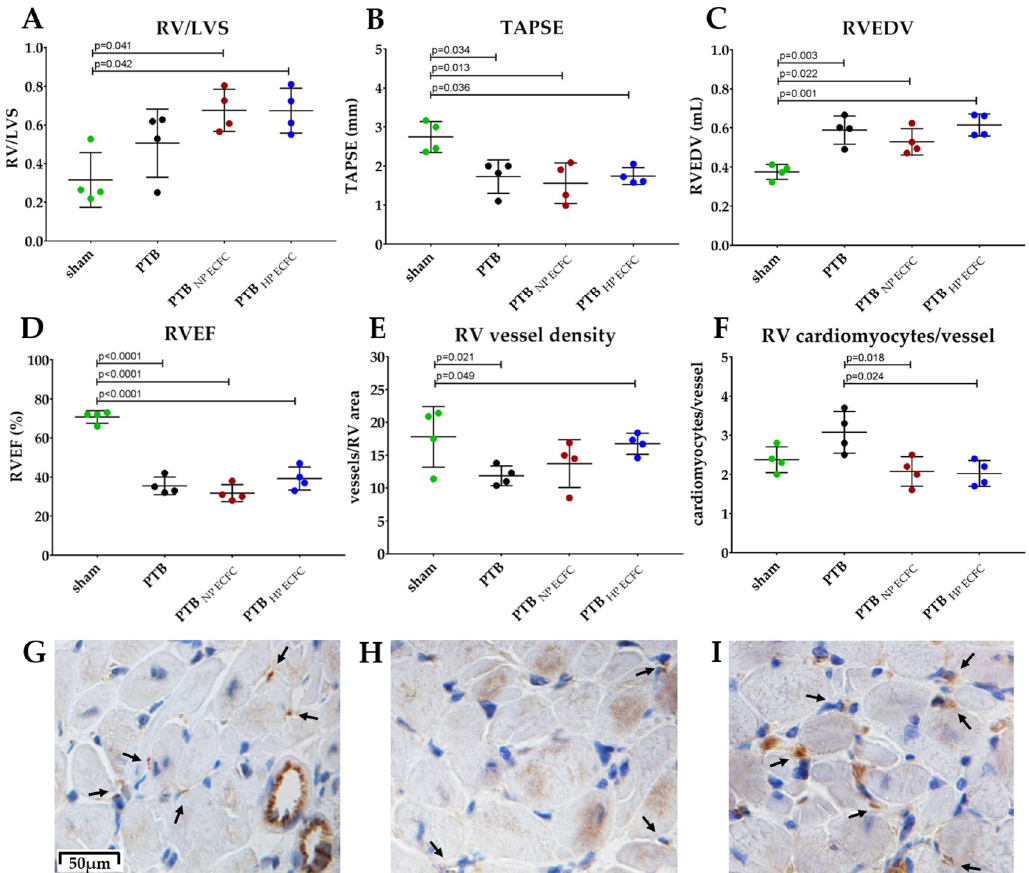
Figure 4. Transplantation of PAH ECFC did not induce reversal of the hemodynamic profile in PTB rats of chronic RV failure. ( A ) RV/LVS weight-ratio was comparable among sham rats (0.32 ± 0.14, green), PTB rats (0.51 ± 0.18, black), PTB rats transplanted with normal proliferative PAH ECFC (0.67 ± 0.11, red), or PTB rats transplanted with highly proliferative PAH ECFC (0.67 ± 0.11, blue). ( B ) TAPSE at evaluation shown of sham (2.7 ± 0.3 mm), PTB (1.7 ± 0.3 mm), PTB normal proliferative PAH ECFC (1.6 ± 0.5 mm), or PTB high proliferative PAH ECFC (1.7 ± 0.19 mm). ( C ) RVEDV of sham (0.38 ± 0.04 mL), PTB (0.59 ± 0.07 mL), PTB normal proliferative PAH ECFC (0.53 ± 0.07 mL) and PTB high proliferative PAH ECFC (0.62 ± 0.06 mL). ( D ) RVEF of sham (71 ± 3%), PTB (36 ± 5%), PTB normal proliferative PAH ECFC (32 ± 4%) and PTB high proliferative PAH ECFC (39 ± 6%). ( E ) Quantification of small vessel density/RV-area indicates significant reversal of the RV myocardial vessel density after transplantation with highly proliferative PAH ECFC (16.8 ± 1.6 vessels/RV-area), sham-animals (17.8 ± 4.6 vessels/RV-area), PTB (11.9 ± 1.5 vessels/RV-area), PTB normal proliferative PAH ECFC (13.7 ± 3.6 vessels/RV-area. ( F ) Cardiomyocytes per vessel ratio for sham (2.4 ± 0.4), PTB (3.1 ± 0.5), PTB normal proliferative PAH ECFC (2.0 ± 0.5) and high proliferative PAH ECFC (2.1 ± 0.6). Mean with SD is shown. Reported p -values are obtained from independent samples two way ANOVA with Bonferroni correction. ( G – I ) Representative phase contrast images of RV-muscle with brown CD31 staining for vessels (black arrow is pointed at a vessel) and nuclei (DAPI) of sham rats ( G ), PTB banded rats ( H ) and PTB banded rats transplanted with highly proliferative PAH ECFC ( I ). Scale bar indicates 50 μm.